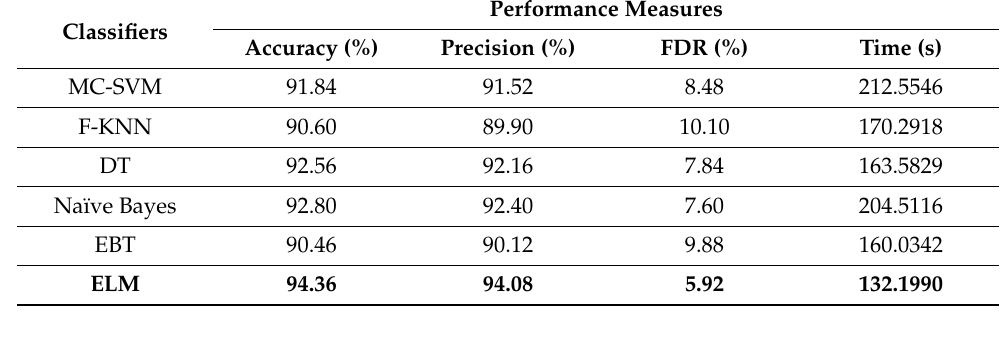
Table 8. Classification accuracy using selected features fusion approach for ISIC2018 dataset.